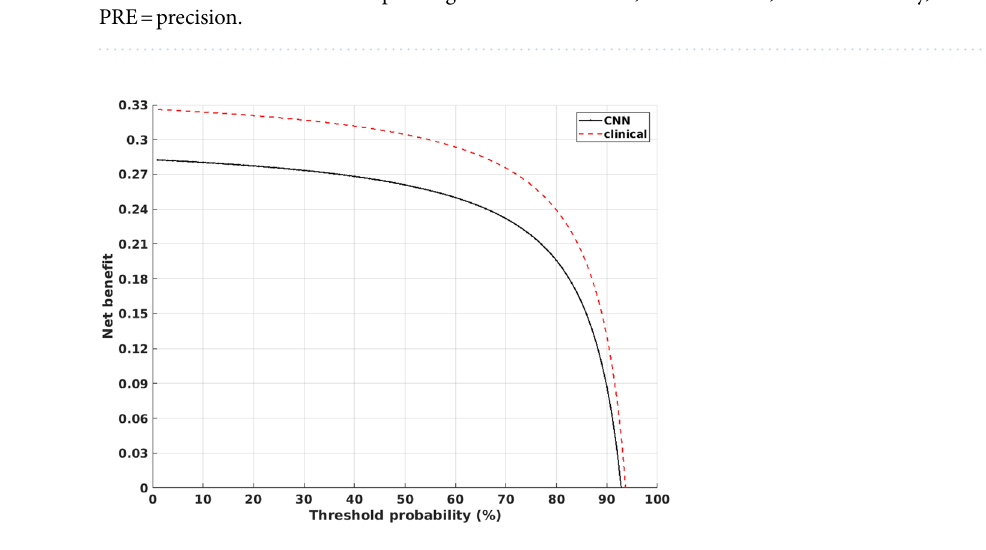
Figure 7. Decision curve with net benefit for all threshold probabilities from 0 to 100% for CNN median over 100 runs and the clinical interpretation using the test data. Only positive values in the range of 0 to 1 for the net benefit are